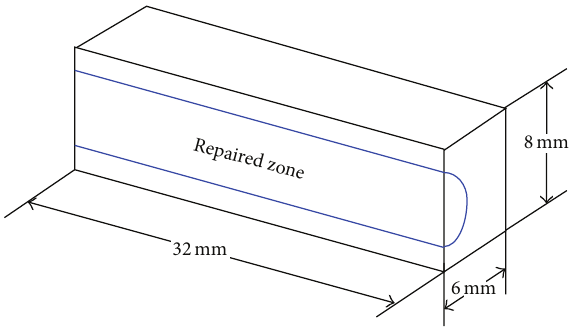
Figure 7: Dimensions of bending test sample.